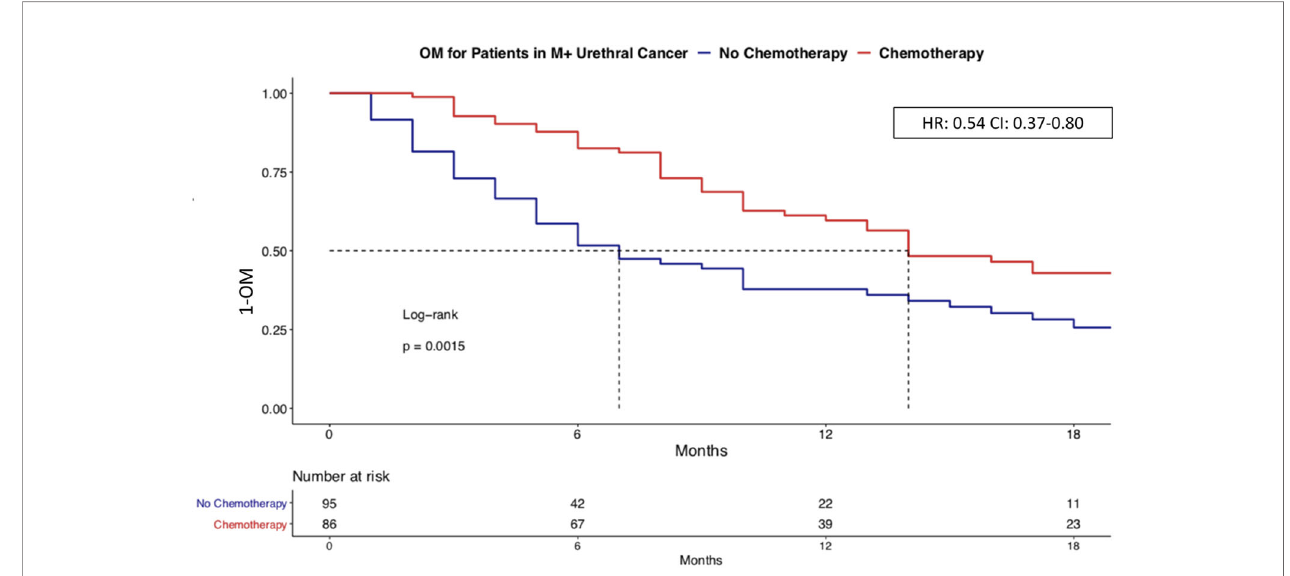
FIGURE 4 | Overall mortality of chemotherapy vs. no chemotherapy in metastatic urethral cancer. Kaplan-Meier plot illustrating overall mortality (OM) for metastatic urethral cancer within comparing chemotherapy (n = 86) vs. no chemotherapy (n = 95). OM, Overall mortality; HR, Hazard ratio; CI, Con fi dence